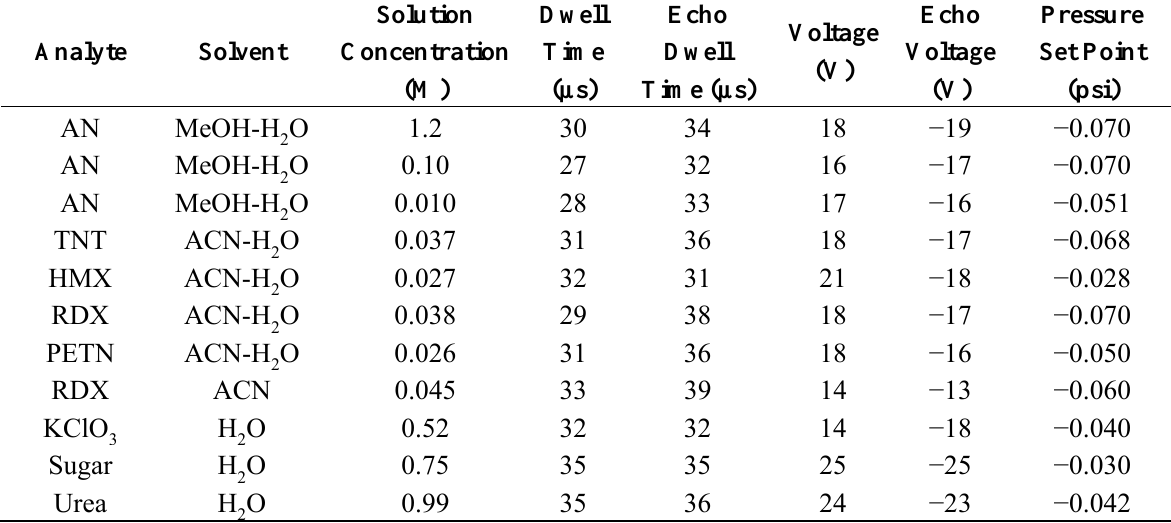
Table 1. Standard waveform parameters for an optimal drop using ACN, ACN and 20% O (by volume), H O, and a 2:1 MeOH:H H 2 2 device